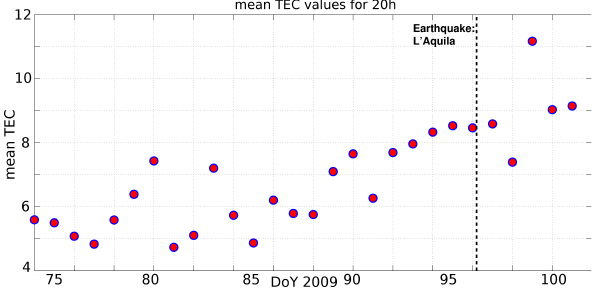
Fig. 1. Mean TEC values at 20h UT from GPS measurements (cor- responding to DEMETER transitions). Accuracy 0.5TECU, de- rived from regional GNSS stations.